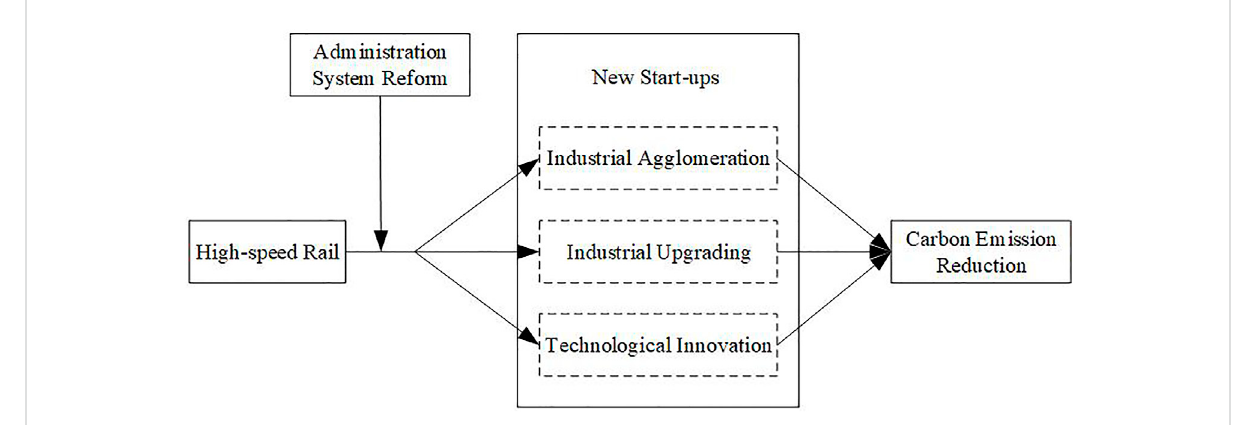
FIGURE 1 The mechanisms between high-speed rail and carbon emission